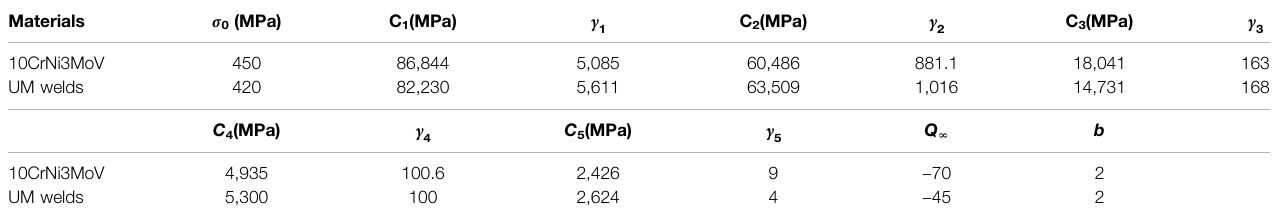
TABLE 3 | Chaboche nonlinear kinematic hardening model parameters of BM and UM. Materials